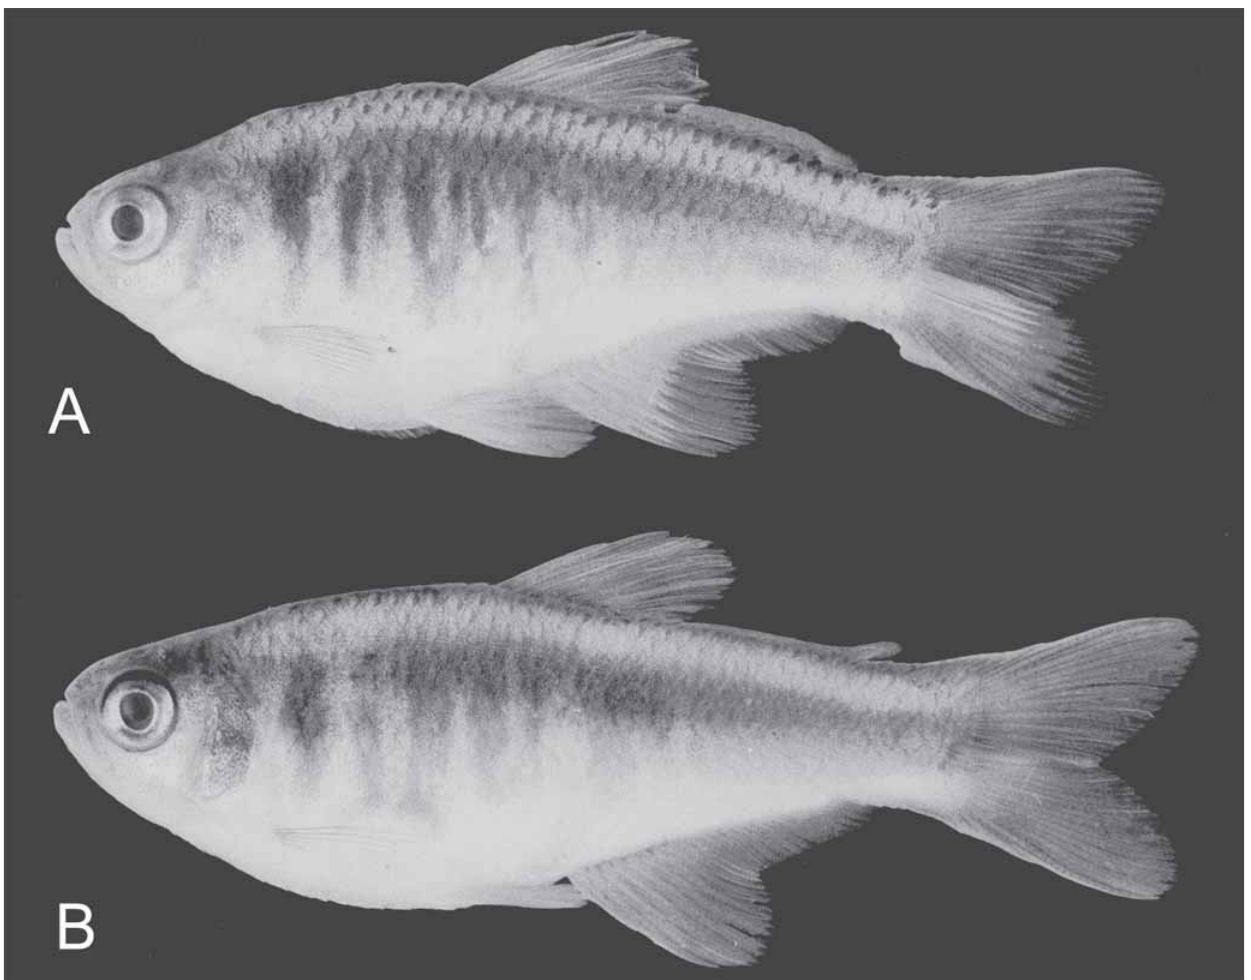
Fig. 1 . Lophiobrycon weitzmani , holotype (A), LIRP 4366, male, SL 26.0 mm; paratype (B), LIRP 4338, female, SL 27.0 mm; Brazil, Minas Gerais, rio Grande basin, Município de Delfinópolis, Estância Carmem Sílvia, córrego Bom Jesus